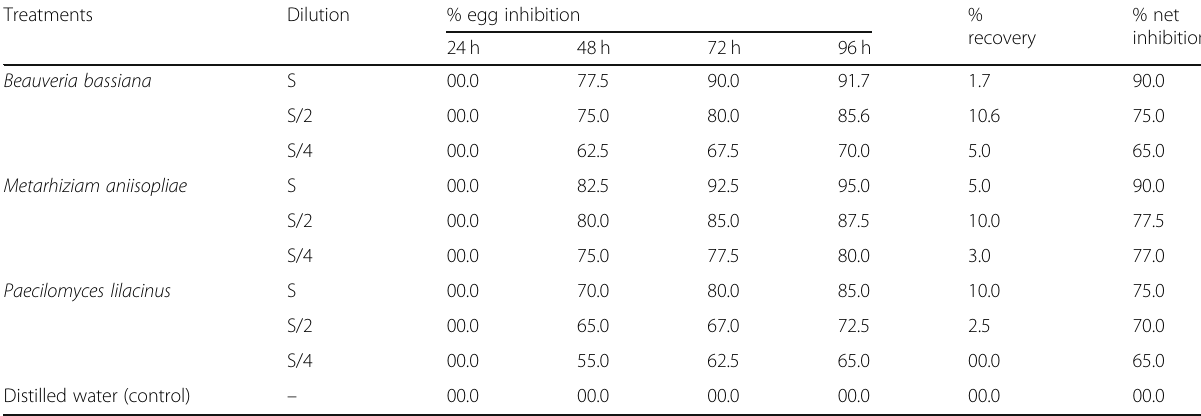
% net recovery inhibition